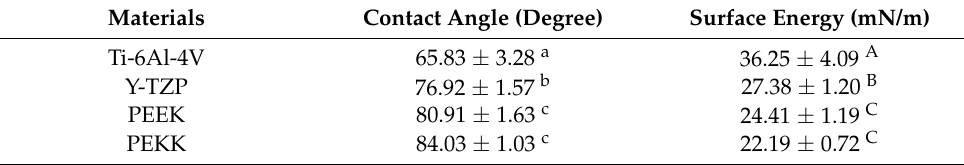
Table 3. Surface characterization testing values for each abutment material (n = 5).